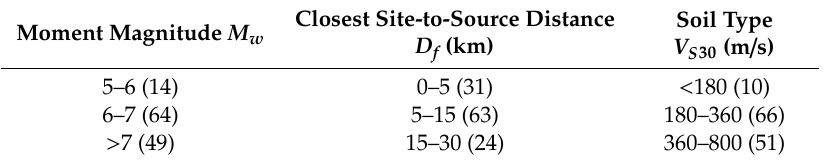
Table 3. Definition of the subsets of seismic records for the sensitivity analysis (the number of records is indicated within brackets).